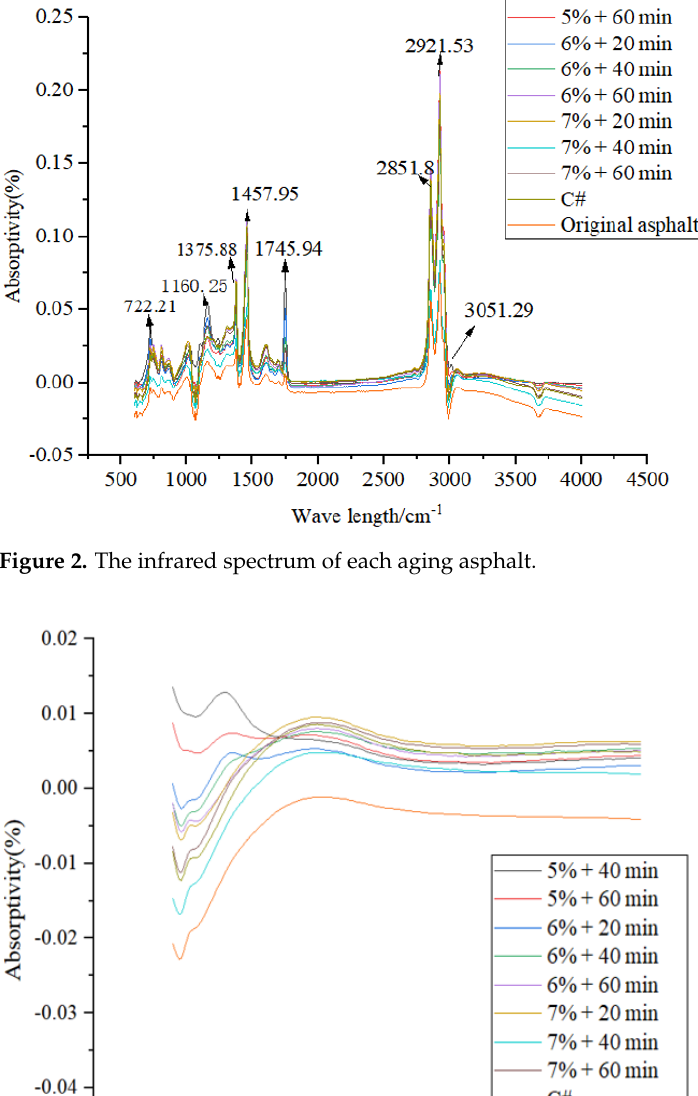
Figure 3. The infrared spectrum of asphalt around 3050 cm −1 .